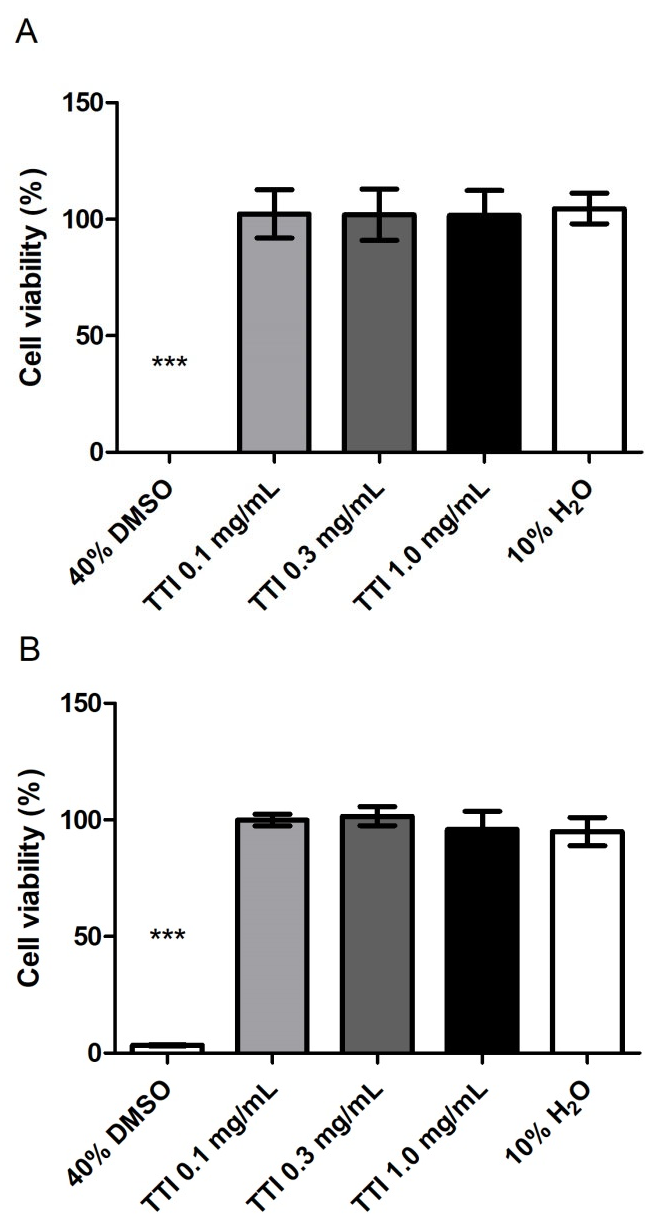
Figure 4. ( A ) Metabolic activity/cell viability of semi ‐ confluent Caco ‐ 2 cell cultures after 4 h in con